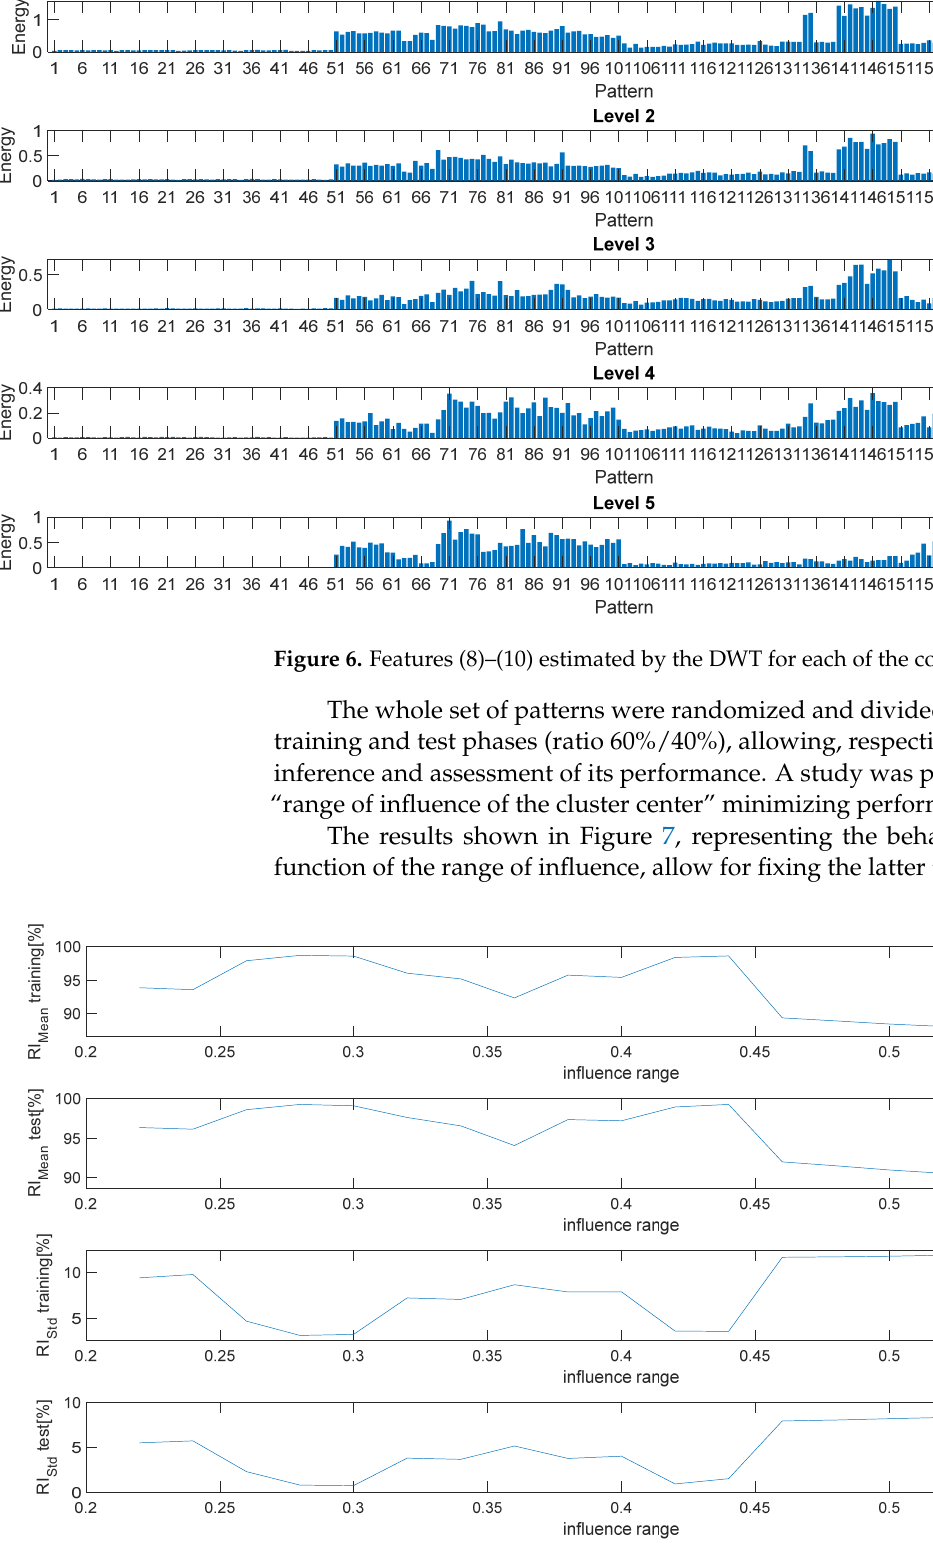
Figure 7. Performance indexes (12)–(13) as a function of the range of influence. Figure 8 shows the results obtained in the case of the optimal range of influence, both for the training and test datasets. In particular, the comparison between the predicted